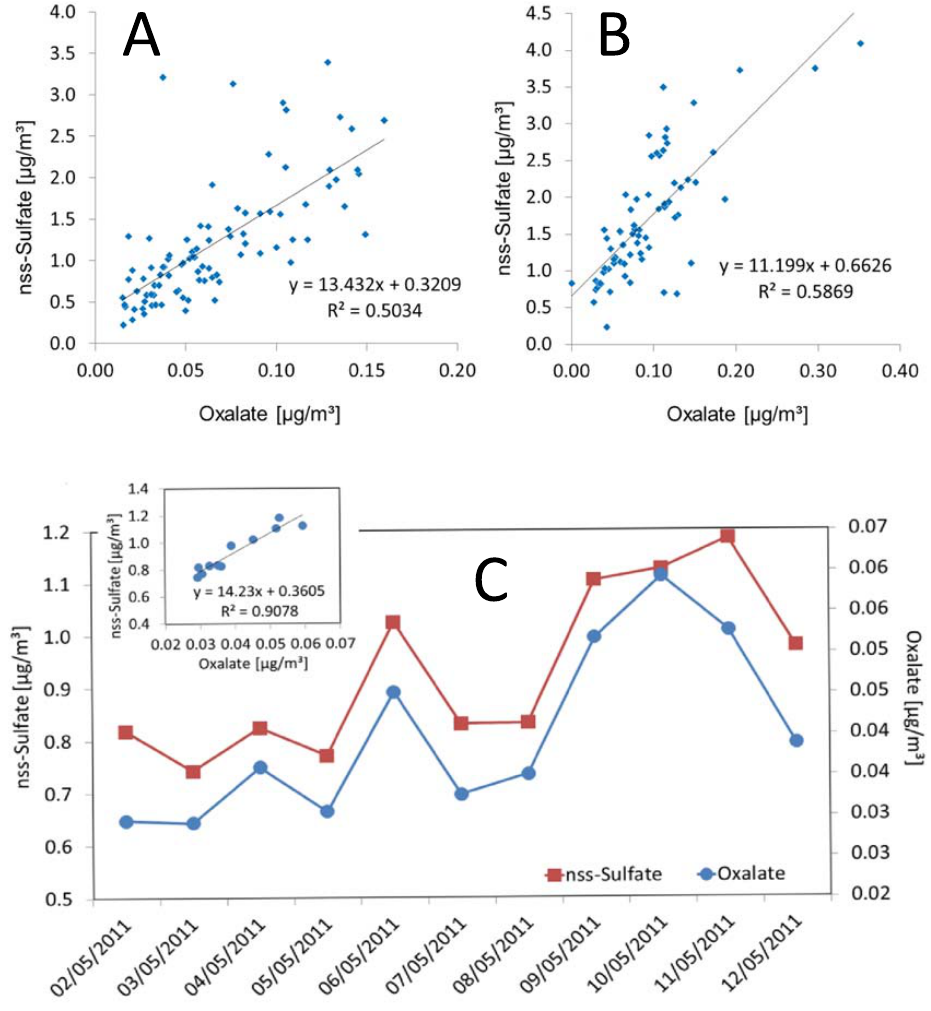
Figure 6. Correlation between nss-sulfate and oxalate in filter samples during 2010/2011. Above: (a) winter, (b) summer. Below: (c) con- centration and correlation during a marine clean air episode in May 2011.